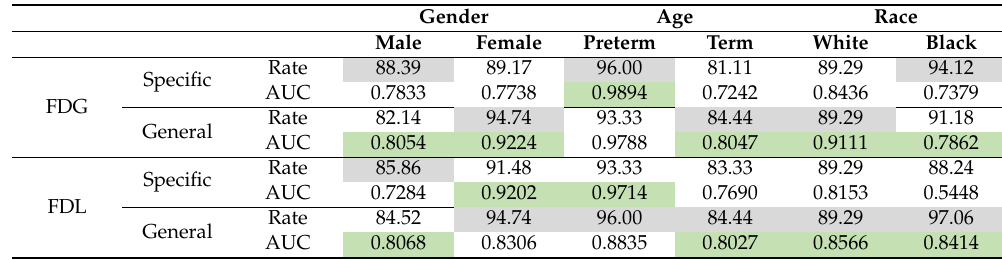
Table 3. Pain assessment results of various factor